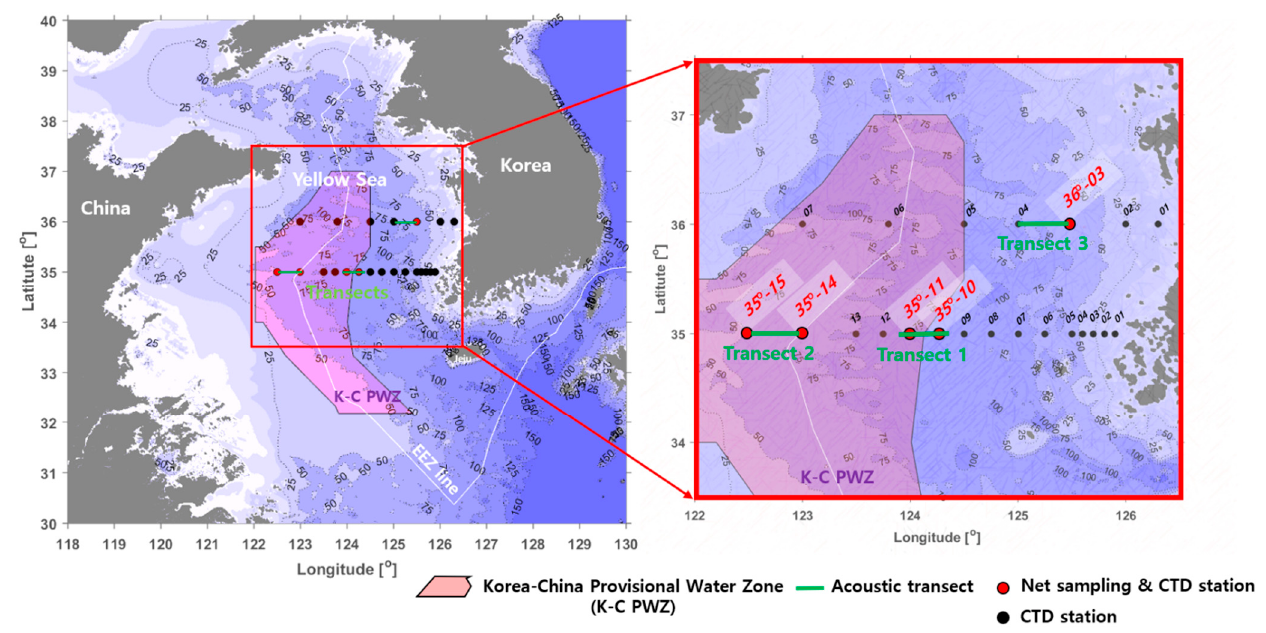
Figure 1. Map of acoustic transects, net sampling, and CTD stations used for evaluation of the sound scattering layer (SSL) including Euphausia pacifica in the Yellow Sea Bottom Cold Water (YSBCW). Table 1. Transect, region, time, start/end position, range, and sea depth information of the acoustic measurements.